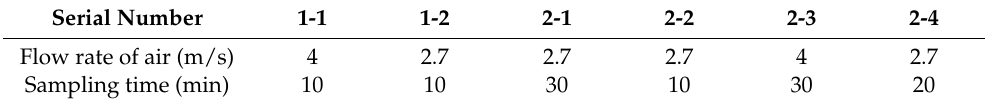
Table 5. Conditions of the